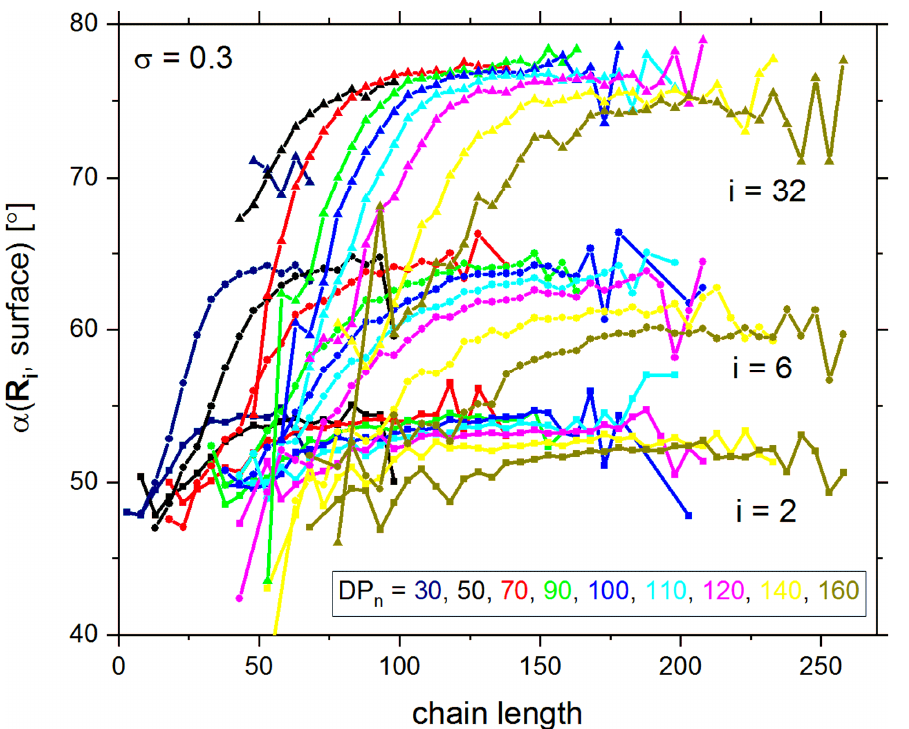
Figure 5. Angle between a vector from the grafting point and a polymer bead located in a given layer i and the grafting surface.